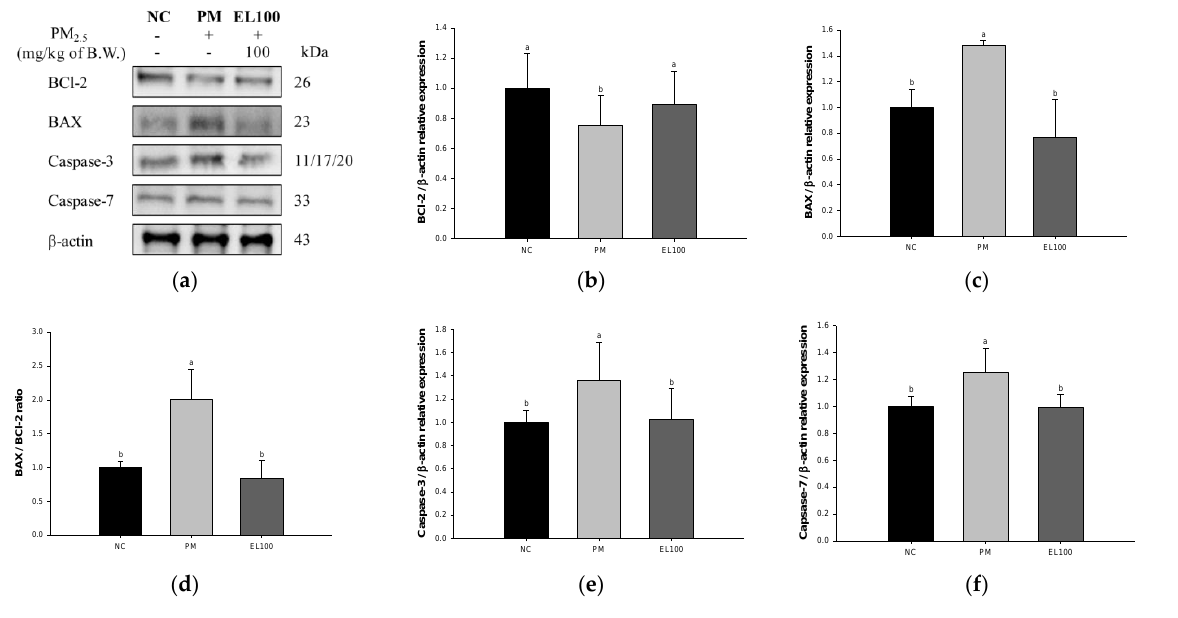
Figure 7. Protective effect of extract of Lonicera japonica on PM 2.5 -induced protein expression of Western blot images ( a ). Protein expression levels of BCl-2 ( b ), BAX ( c ), BAX/BCl-2 ratio ( d ), Caspase-3 ( e ), and Caspase-7 ( f ). Results shown are mean ± SD ( n = 3). Data were statistically represented at p < 0.05, and different lowercase letters indicate statistical significance.